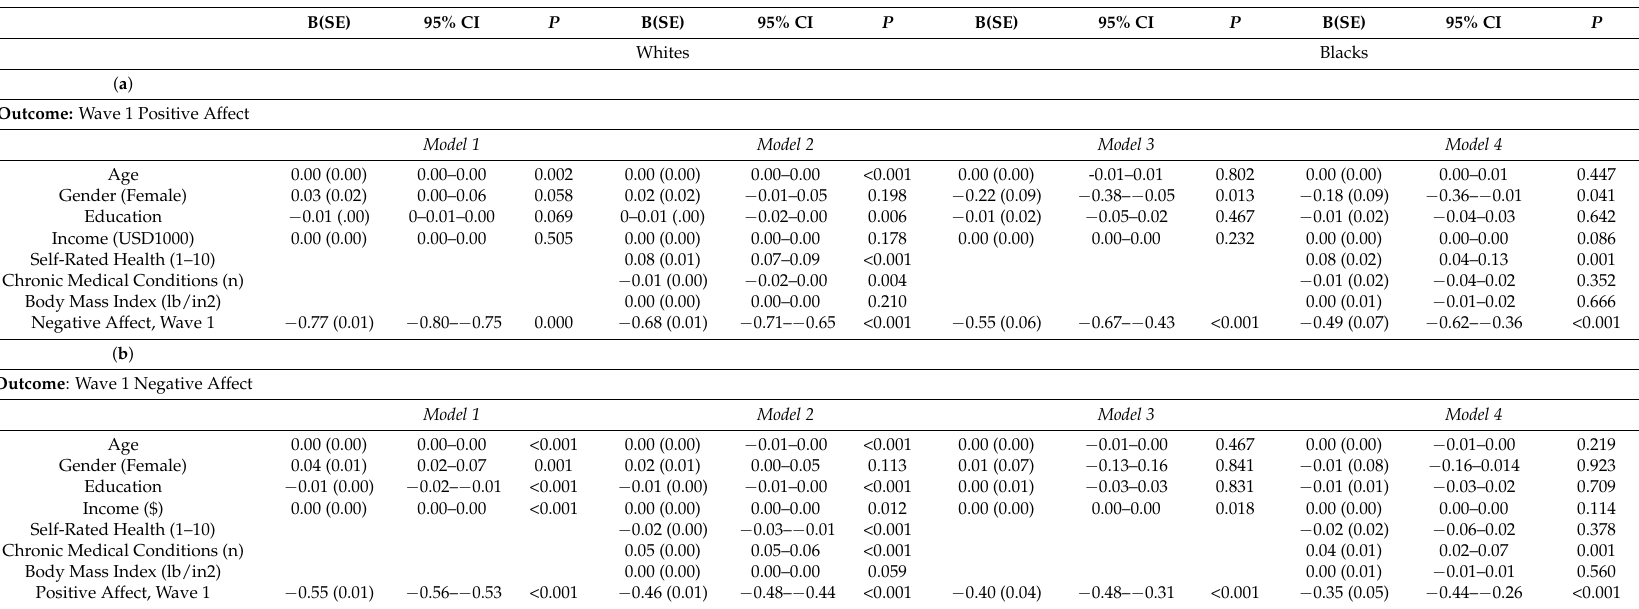
Table 5. Predictors of wave 1 positive and negative affect in White and Black